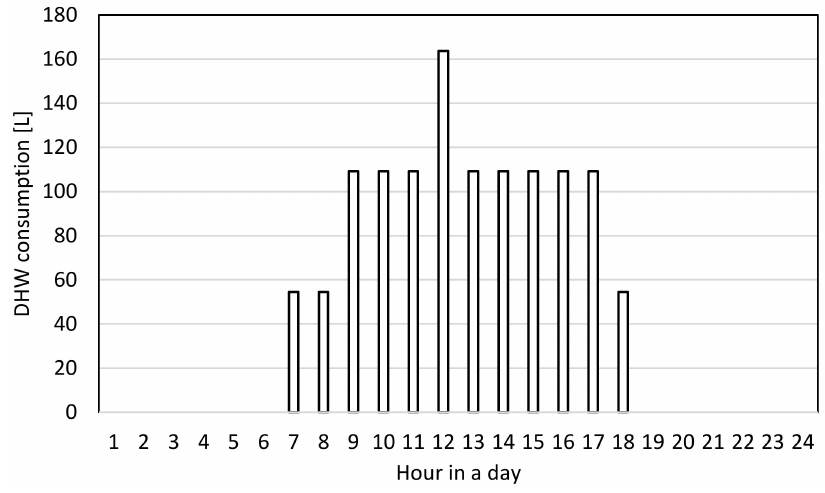
Figure 4. Assumed DHW consumption profile.